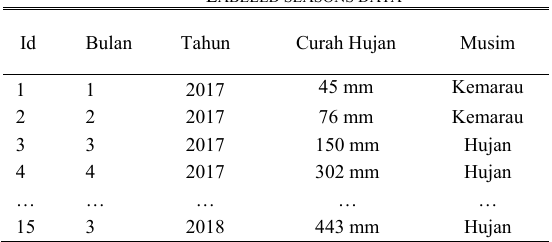
TABLE 3 L ABELED SEASONS